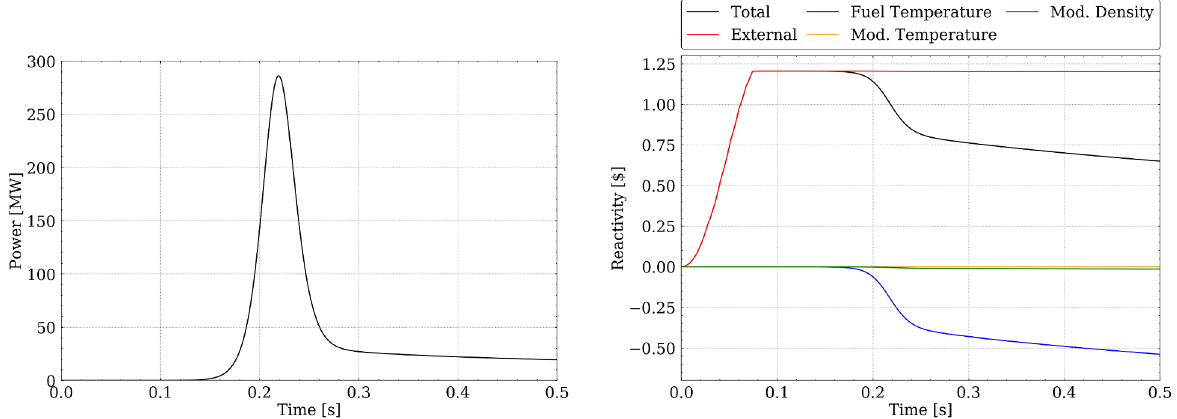
Figure 3: Power (left) and reactivity contributions (right) as a function of time of Test 43 for cold-startup condition calculated with